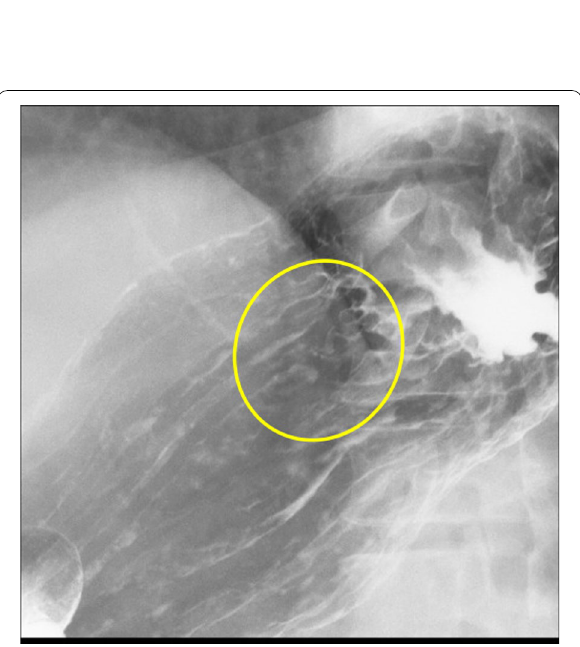
Fig. 2 Upper gastrointestinal series showing that the tumor had a convergence of folds suggesting submucosal